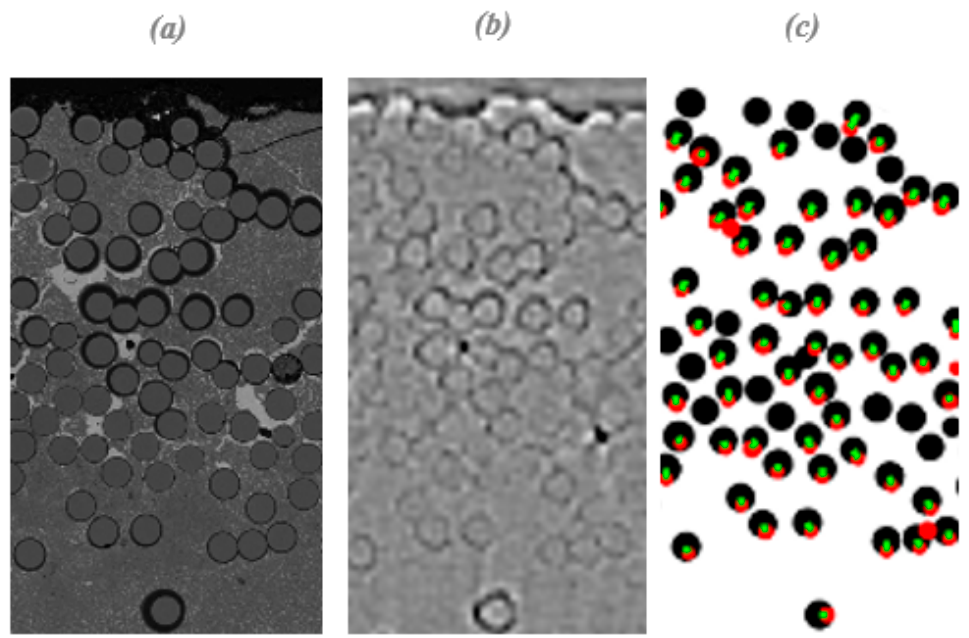
Figure 9. Higher magnification views of images and segmentations from a small region within Figure 3, showing the effect of damage and image artifacts near the edge of the test specimen: ( a ) optical image; ( b ) CT image; ( c ) superposition of fiber segmentation masks derived from optical image (black) and CT image slice (red). Green lines connect corresponding fibers in the two masks.